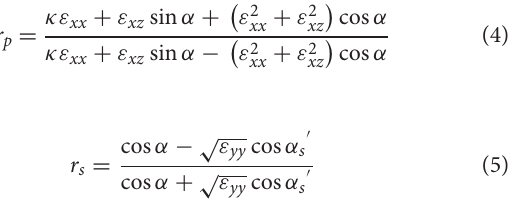
Frontiers in Physics |